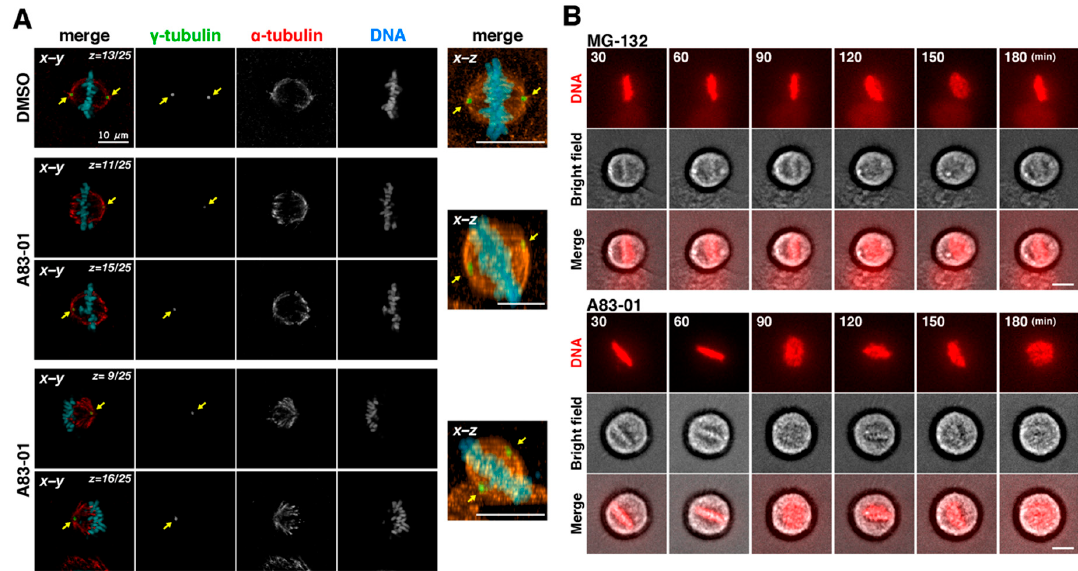
Figure 5. Rotation of mitotic spindle in A83-01-treated cells. ( A ) After incubation with RO-3306 for 20 h, cells were released in the presence of 3 µM A83-01 for 1 h, fixed, and stained for α -tubulin, γ -tubulin and DNA. (Left), z –stack images were acquired by using a confocal microscopy, and one or two focal planes ( x - y images) were shown. (Right), the x – z projections from the z –stack images of 25 focal planes (1 µm apart). Arrows indicate the positions of centrosomes. Scale bars, 10 µm. ( B ) After incubation with RO-3306, cells were released in the presence of 0.1 µM Hoechst 33342 with 10 µM MG-132 or 3 µM A83-01. MG-132 or A83-01 was added into the culture at the time of release or at 30 min after the release, respectively. Then, mitotic progression was monitored every 5 min by time-lapse imaging until 3 h after the release. Fluorescence of Hoechst 33342 and bright field images are shown. Scale bars, 10 µm. The line graphs shown in Figure 4C were created based on the results of time-lapse